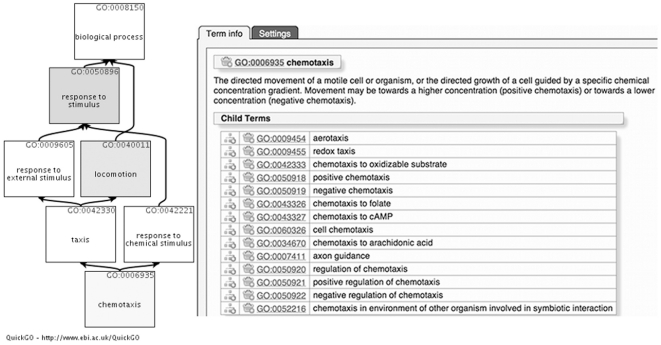
QuickGO term display.QuickGO (www.ebi.ac.uk/QuickGO) ancestor chart showing information for GO:0006935 ‘chemotaxis’ and its ‘is_a’ parent relationships within the hierarchical directed acyclic graph. The GO terms ‘chemotaxis’, ‘locomotion’ and ‘response to stimulus’ are highlighted to illustrate their parent-child relationships. The child term details are displayed for the GO term ‘chemotaxis’.